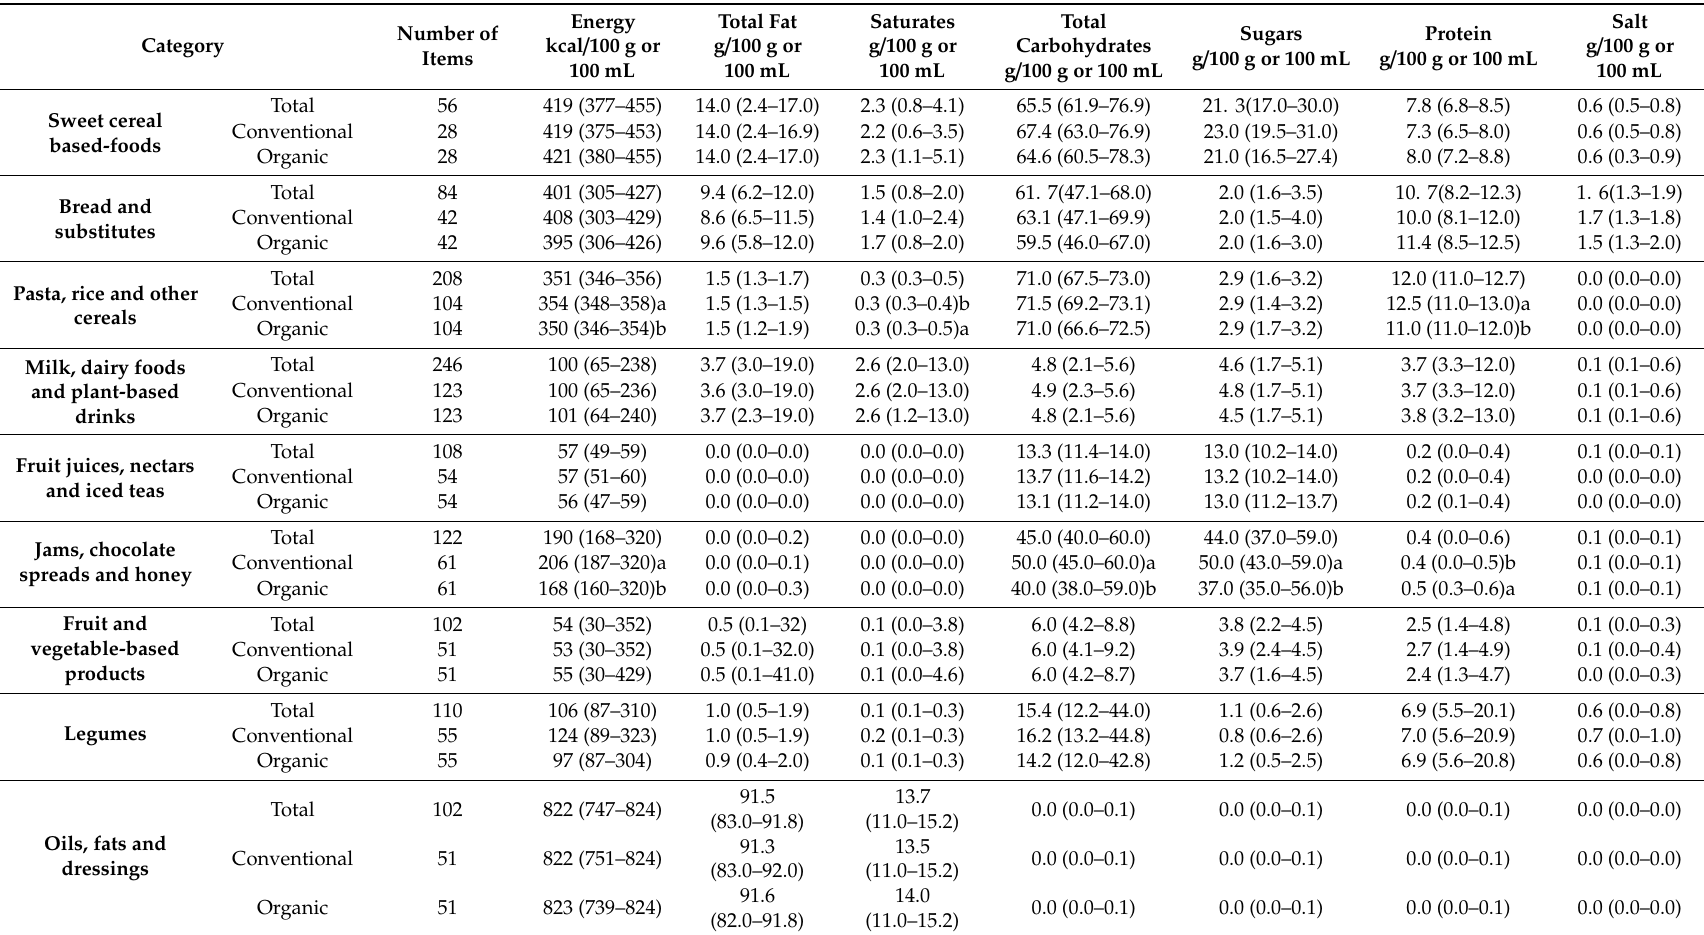
Table 2. Energy, macronutrients, and salt across the considered